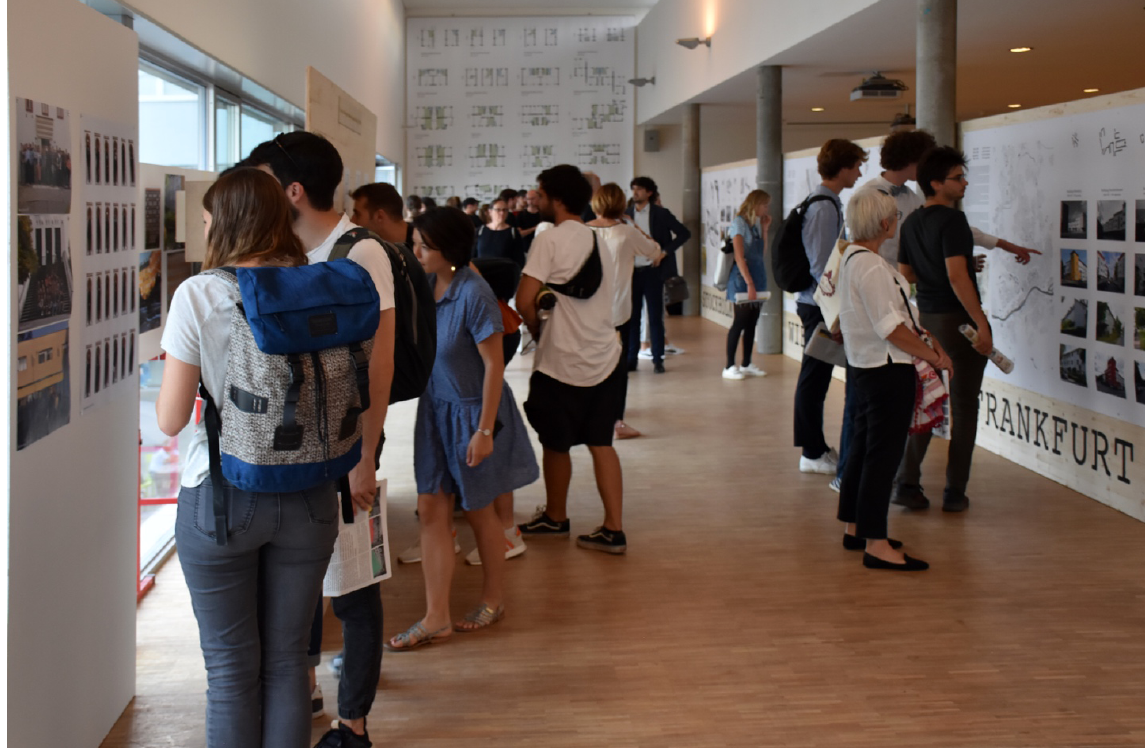
Figure 5. The main hall of the exhibition at the opening. Source: